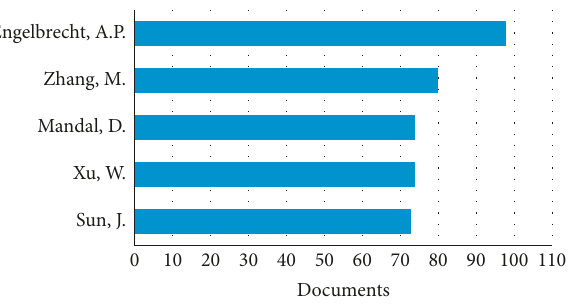
Figure 5: Top researchers on PSOA research (2001–2021).